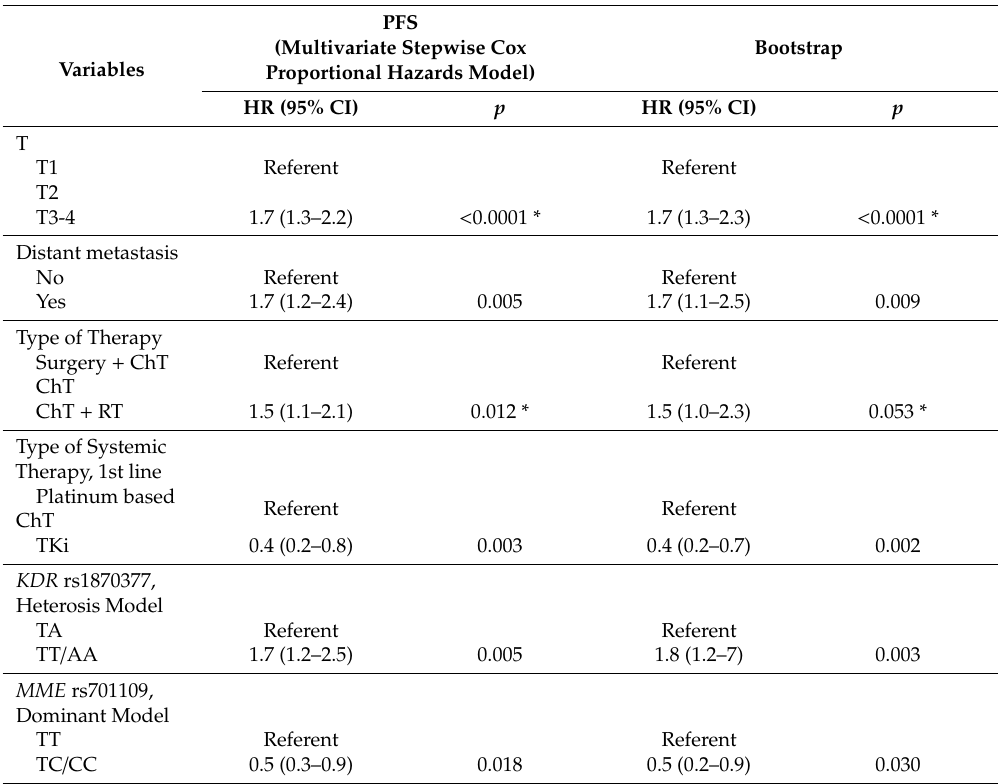
Table 2. Multivariate analysis for progression-free survival (PFS) in the discovery cohort ( n = 167).